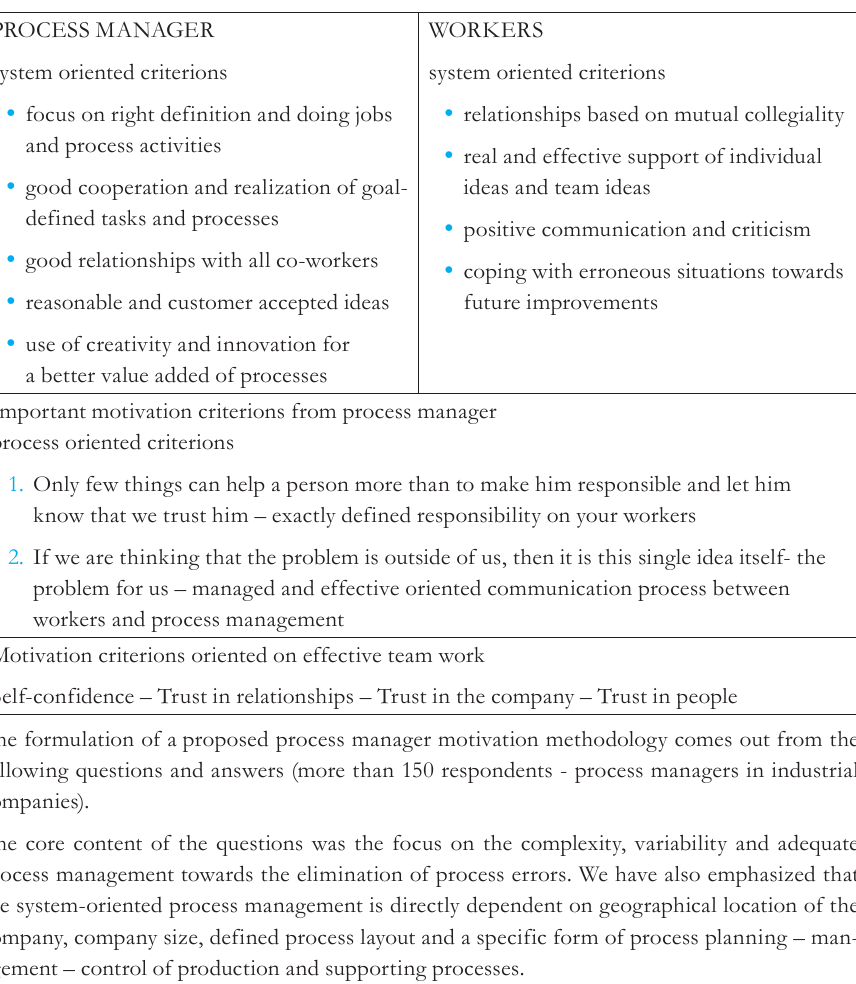
Tab. 1 - Motivation criterions for process managers and their